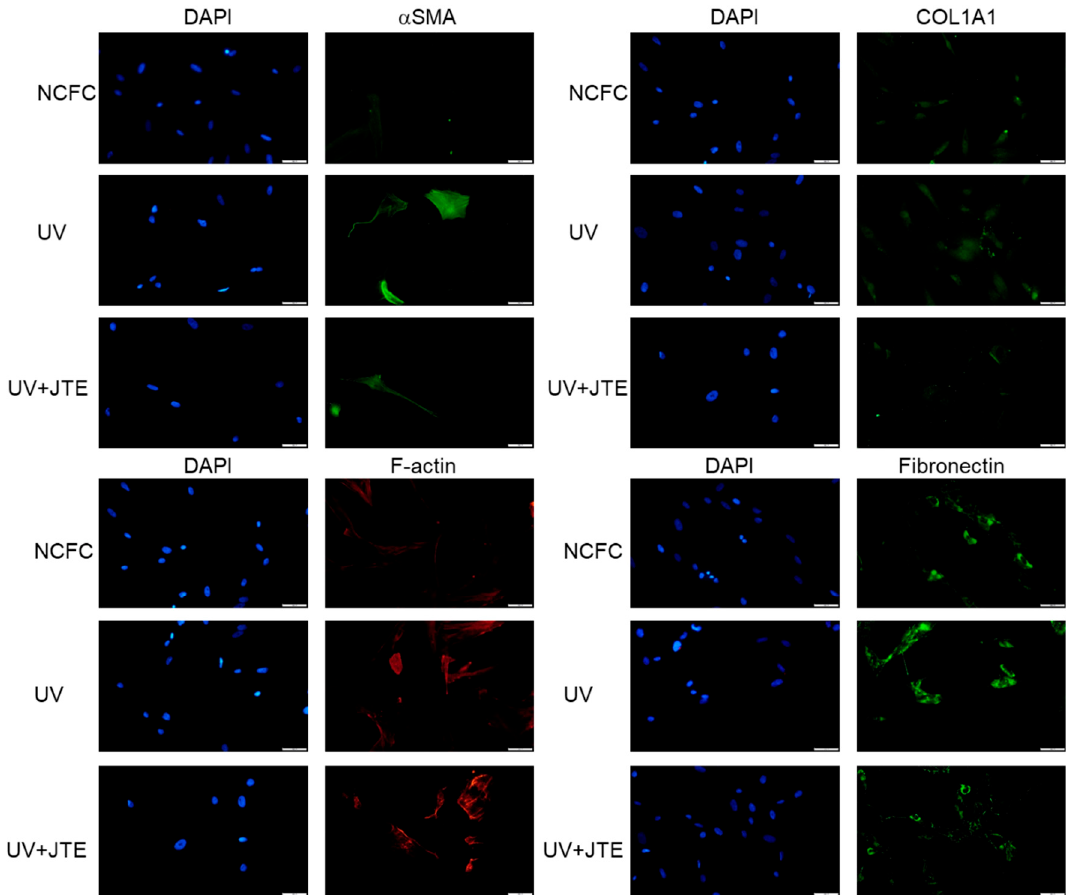
Figure 12. Immunocytochemistry of α -SMA, COL1A1, fibronectin, and F-actin in NCFCs and UV-NCFCs with or without JTE-013 . The left panels show cells stained with DAPI. The right panels show cells stained for either α -SMA, COL1A1, fibronectin, or F-actin. These components were upregulated in UV-NCFCs compared to NCFCs, and those changes were attenuated with JTE-013. Bar, 200 µm.